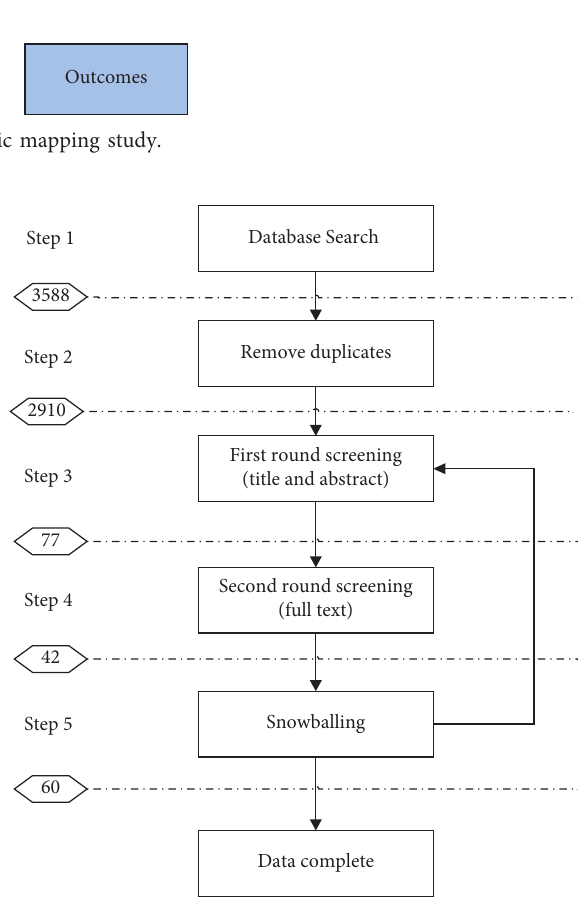
Figure 2: Database search and paper screening